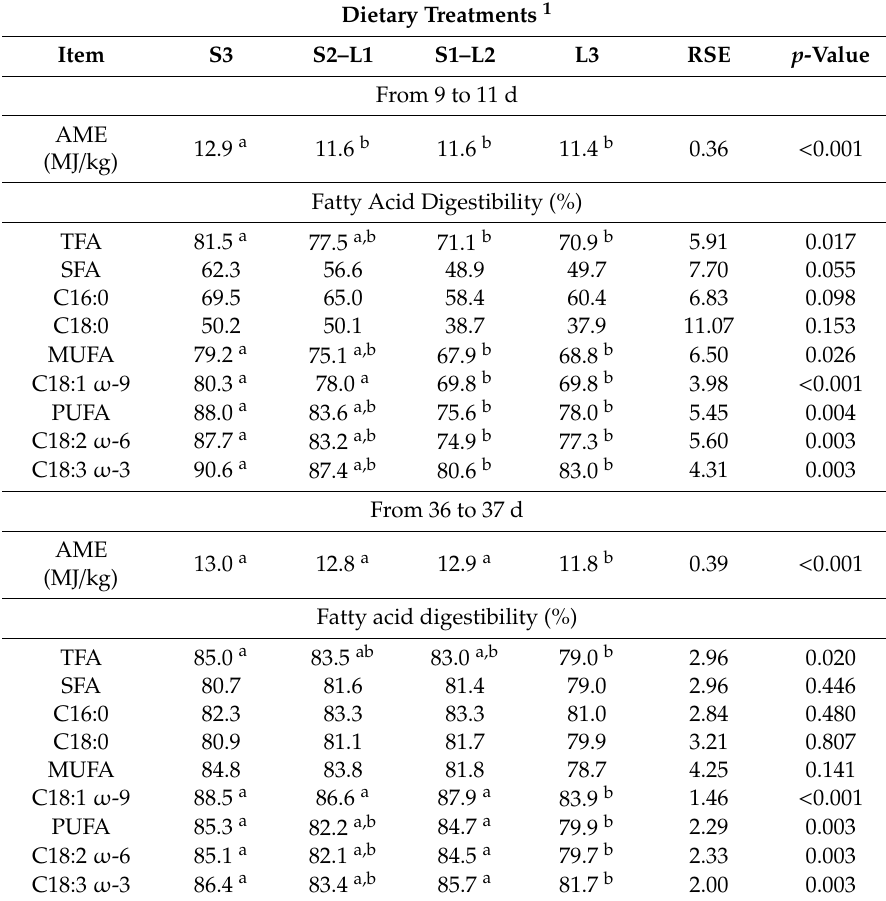
Table 7. Feed apparent metabolizable energy value and fatty acid digestibility of starter and grower–finisher broiler chicken diets according to added fat sources (Experiment